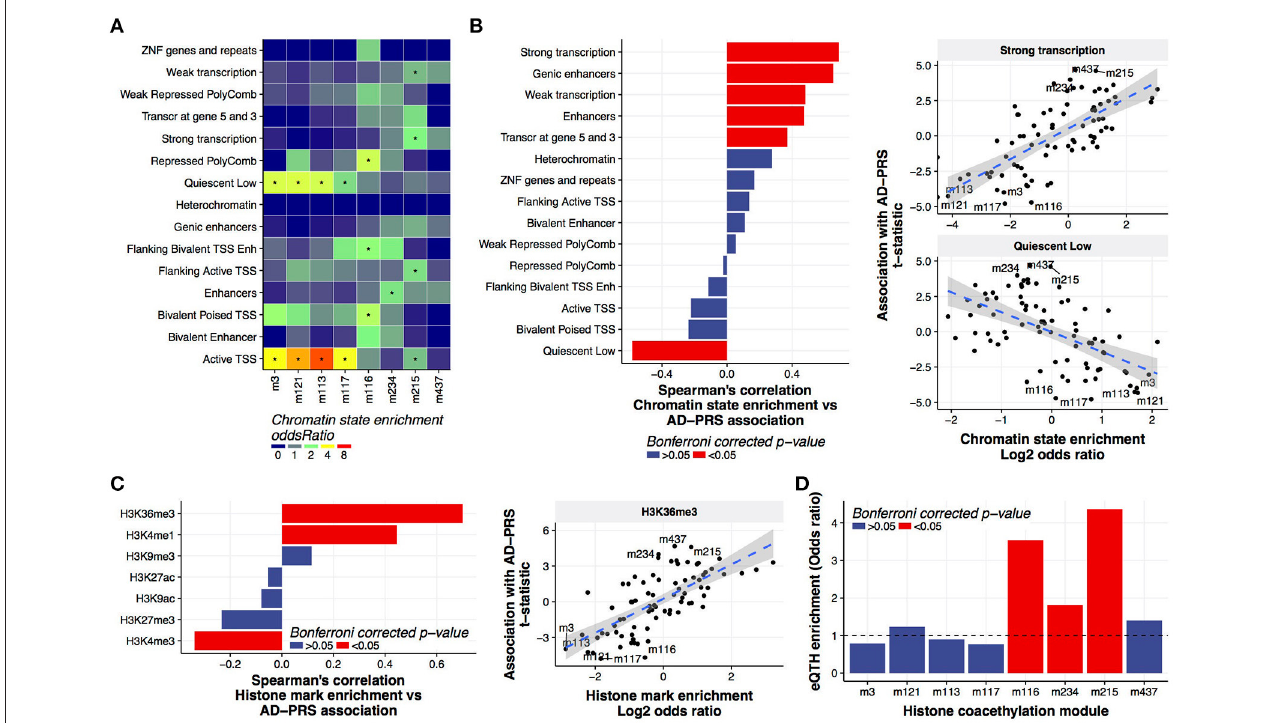
FIGURE 3 | Characterization of histone coacetylation modules associated with AD-PRS (A) . Chromatin state enrichment of histone coacetylation modules. Overlap between histone coacetylation modules and 15 chromatin states from the mid-frontal gyrus was assessed using the Fisher’s exact test via the LOLA method. An asterisk indicates Bonferroni-corrected p < 0.05 (B) . Correlation between chromatin state enrichment of coacetylation modules and their associations with AD-PRS (C) . Correlation between histone mark enrichment of coacetylation modules and their associations with AD-PRS. Overlap between histone coacetylation modules and seven histone marks from the mid-frontal gyrus was assessed via the LOLA method. The enrichment stats (log2 of odds ratio) were compared with association stats with AD-PRS (D) . Enrichment of eQTHs in modules. The enrichment was tested using the Fisher’s exact test.